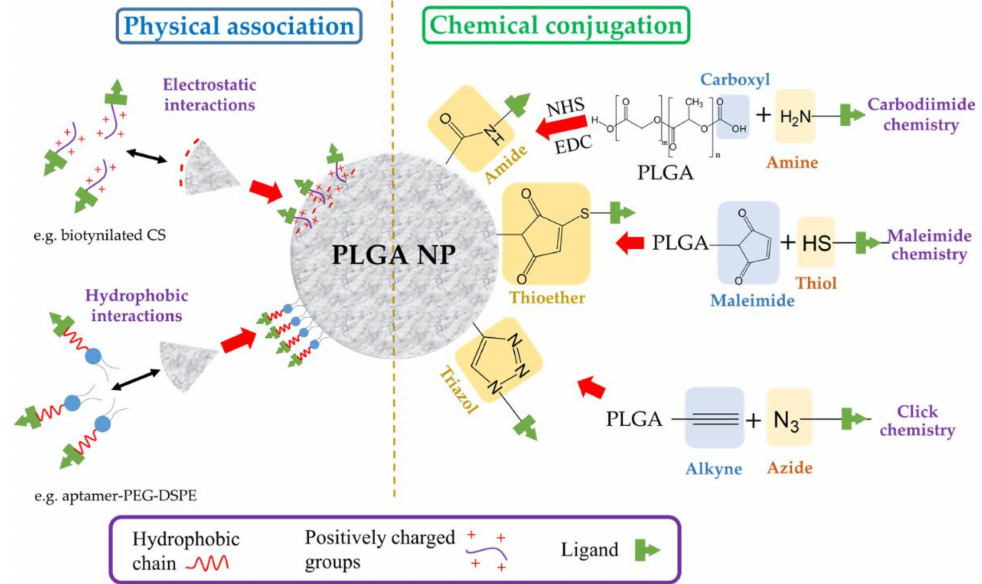
Figure 5. Major methods used for the attachment of targeting ligands on the surface of PLGA NPs. DSPE: 1,2-distearoyl- sn -glycero-3-phosphoethanolamine; EDC: 1-ethyl-3-(3-dimethylaminopropyl) carbodiimide; NHS: N